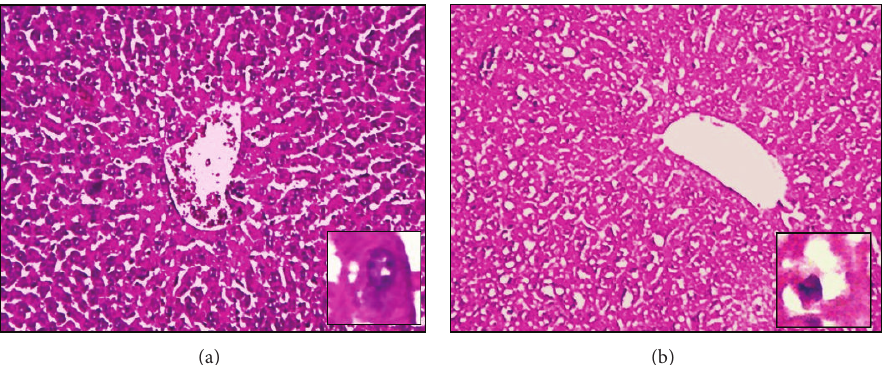
Figure 2: Liver histological analysis of mice exposed to diphenyl ditelluride 10 𝜇 mol/kg for 7 days. (a) Hepatocytes of mice control: cells with normal nuclei, dispersed chromatin and nucleolus arranged towards hepatic central vein (detail in 40x); (b) liver section of mice treated with diphenyl ditelluride showing cytoplasmic vacuolation, edema, and hyperchromatic nuclei (detail in 40x) (H&E 10x). The picture is a representation of three independent experiments.